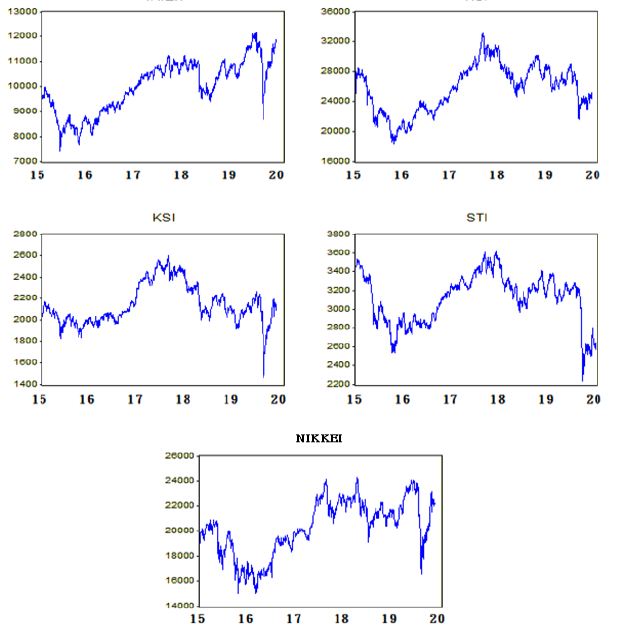
Figure 1: Daily closing prices for stock market indices of the Four Asian Tigers and Japan over the period April 2, 2015 to July 3,